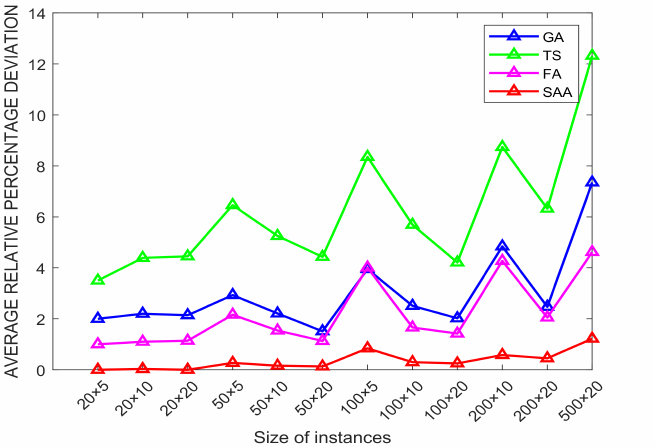
Figure 8. Relation graph for different